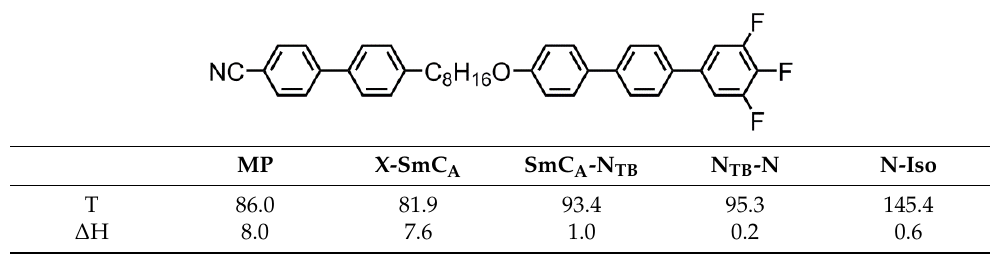
Table 1. Molecular structure (top), transition temperatures (T, ◦ C) and associated enthalpies of transition [ ∆ H, kJ mol − 1 ] for CB8OFFFT , determined by differential scanning calorimetry (DSC) at a heat/cool rate of 10 ◦ C min − 1 . Transition temperatures were recorded on the heating cycle with the exception of the monotropic X-SmC A transition, which was recorded on cooling. Uncertainty in our DSC measurements is estimated to be ± 0.1 ◦ C and ± 0.05 j g − 1 , corresponding to ~0.03 kJ mol − 1 .